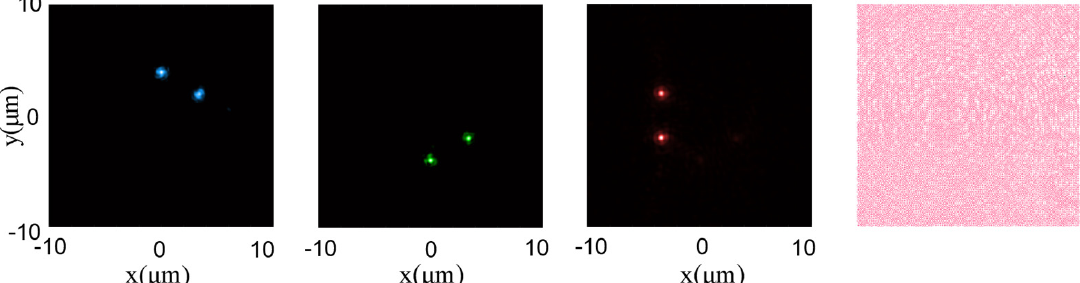
Figure 6. The first three images from left to right, respectively, represent the normalized intensity distribution of the focal planes of B, G, and R waves, while the final image is the gds layout of the metalens structure.